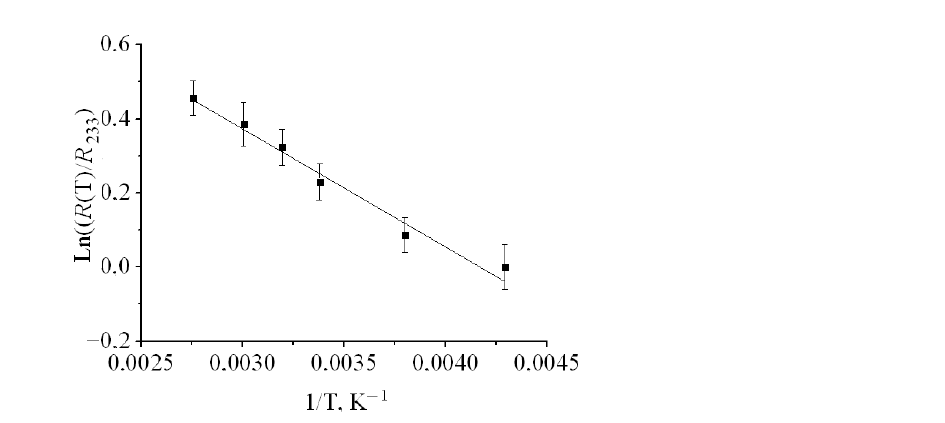
Figure 3. Dependence of the logarithm of the reduced tweed structure period on the reciprocal tem- perature.